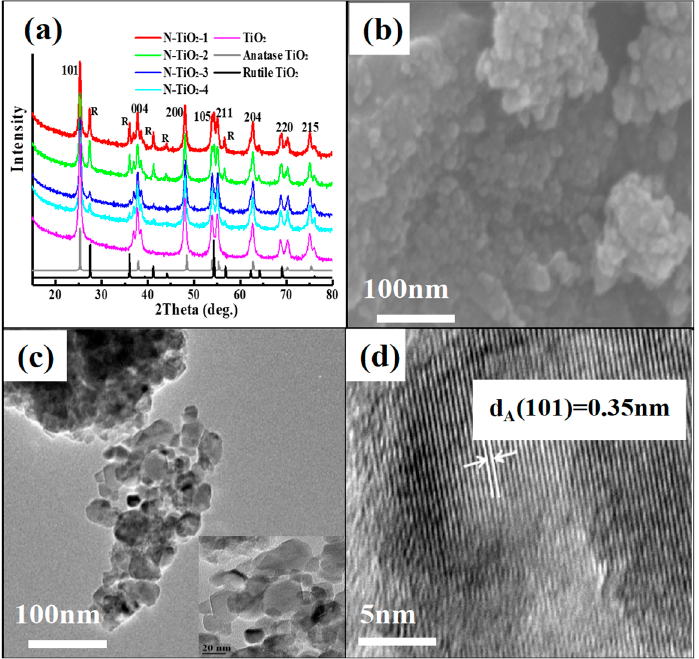
Figure 3. The XRD spectra of TiO 2 and N-TiO 2 with different doping ratios ( a ); SEM image ( b ); TEM images of 100 nm ( c ); and 5 nm ( d ) measuring scales of N-TiO 2 -1 nanoparticles.